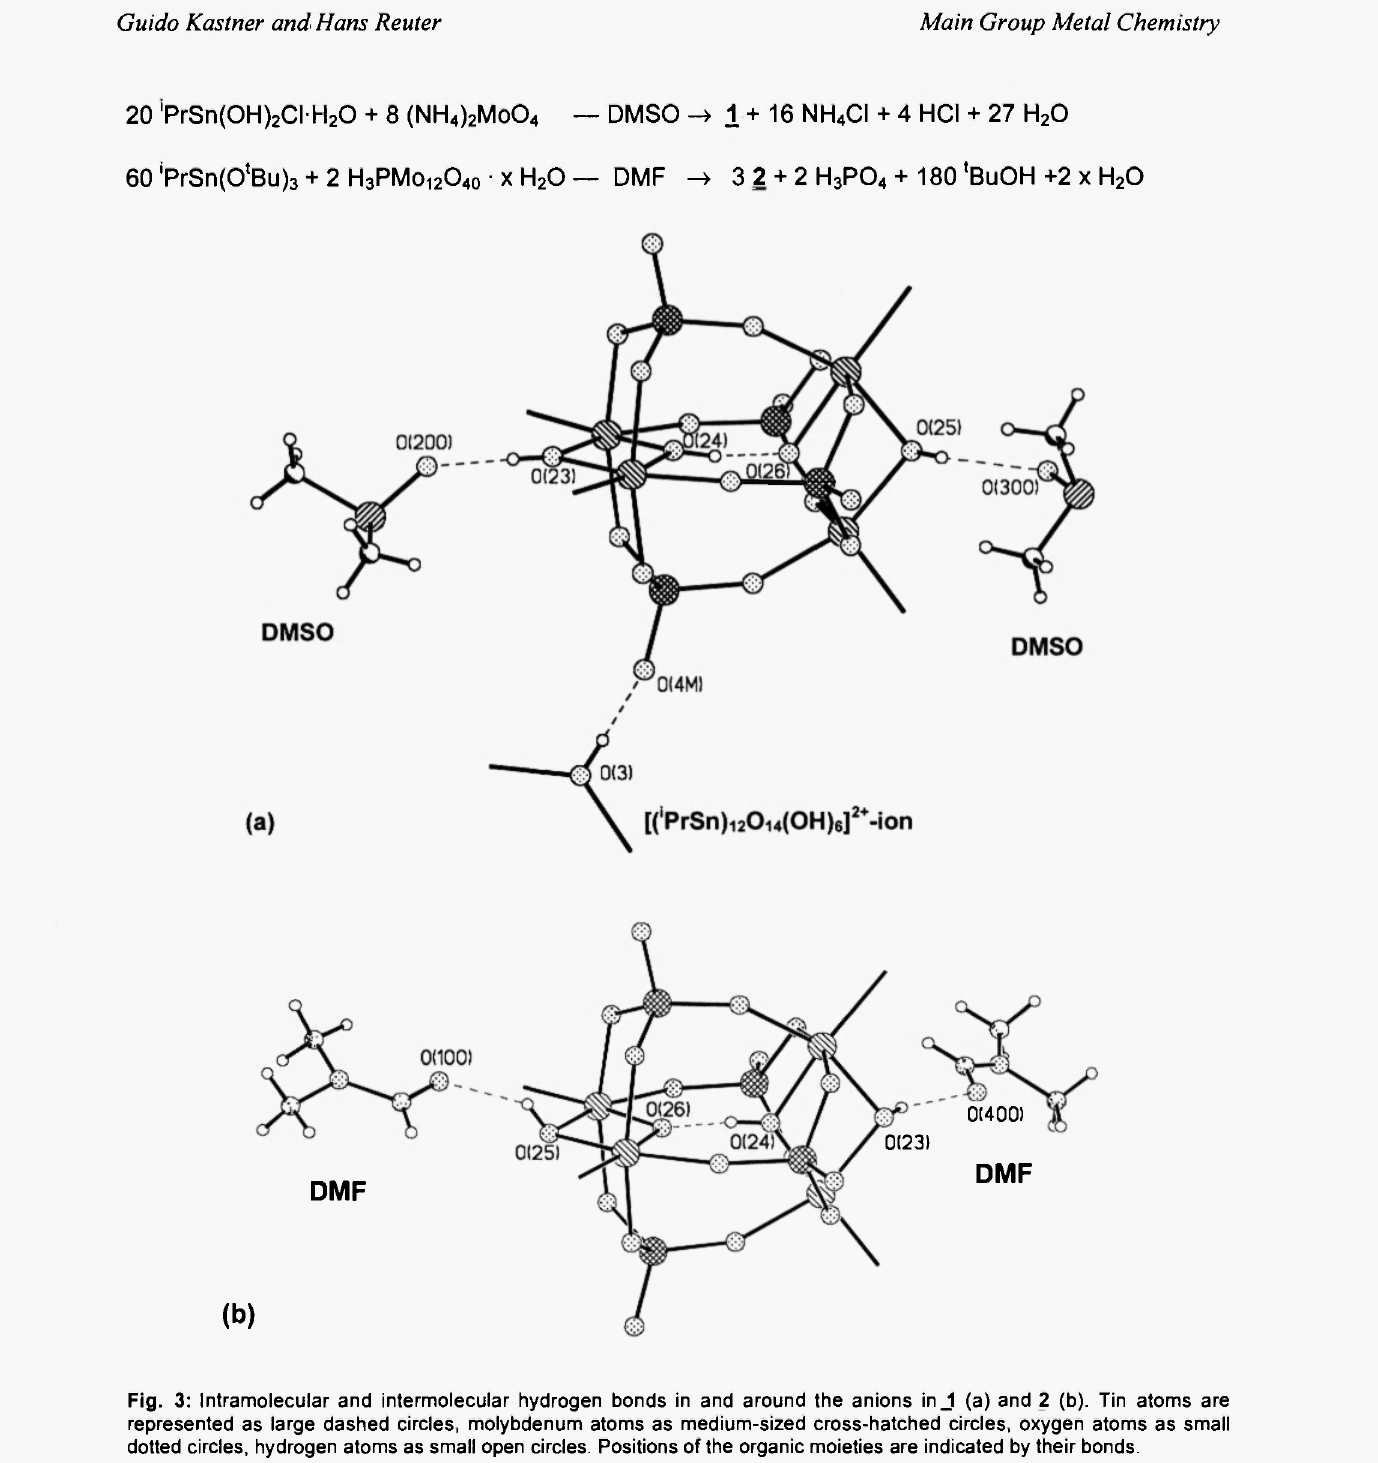
Fig. 3: Intramolecular and intermolecular hydrogen bonds in and around the anions i nj (a) and 2 (b). Tin atoms are represented as large dashed circles, molybdenum atoms as medium-sized cross-hatched circles, oxygen atoms as small dotted circles, hydrogen atoms as small open circles. Positions of the organic moieties are indicated by their